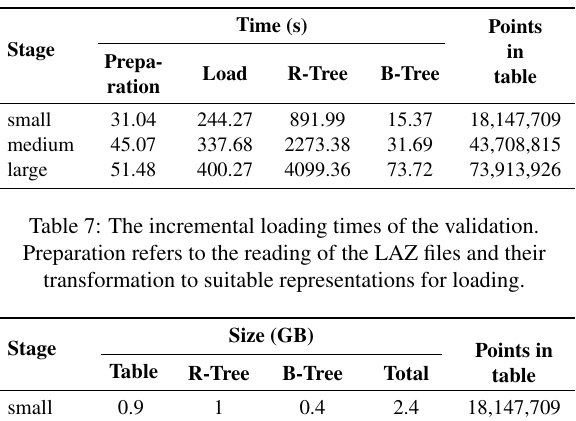
Table 9: The query response times and the number of points returned by the queries of the validation benchmark.